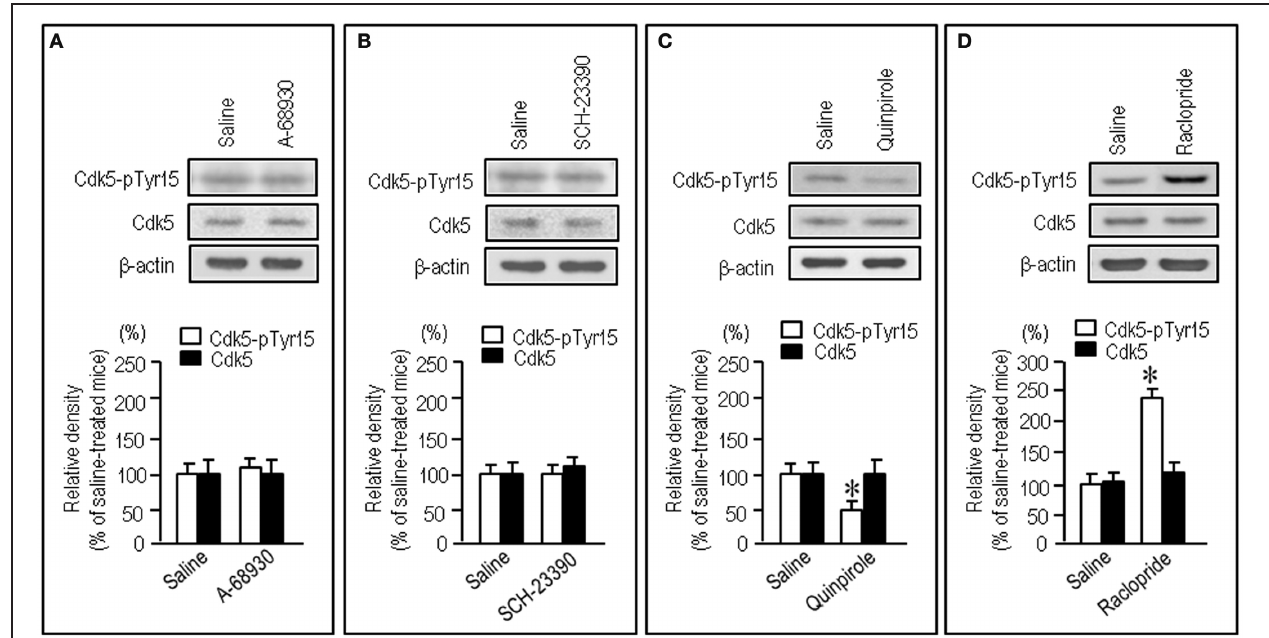
FIGURE 3 | Negative regulation of striatal phosphorylation of Tyr15-Cdk5 through a D2R-mediated mechanism. Western blot analysis was carried out on the striatal extracts from mice that received saline, A-68930 (2mg/kg), SCH-23390 (0.5mg/kg), quinpirole (5mg/kg), or raclopride (1mg/kg), 30min